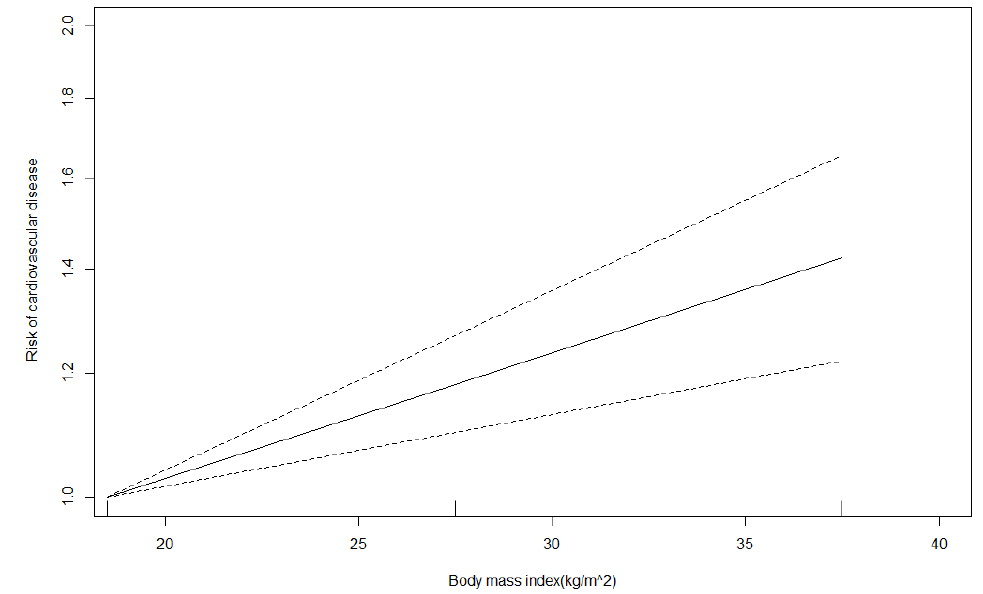
Figure 3. Dose-response analysis of body mass index and the risk of cardiovascular disease.